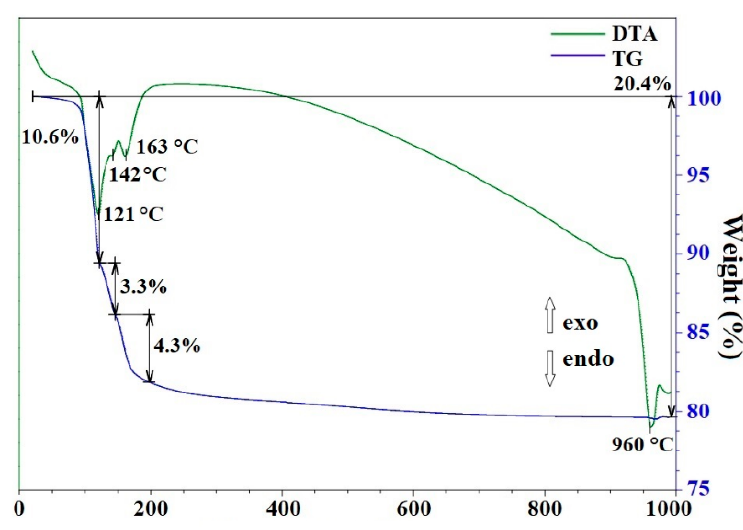
Figure 6. IR spectra of samples 3 (curve 1), 4 (curve 2), and 5 (curve 3).